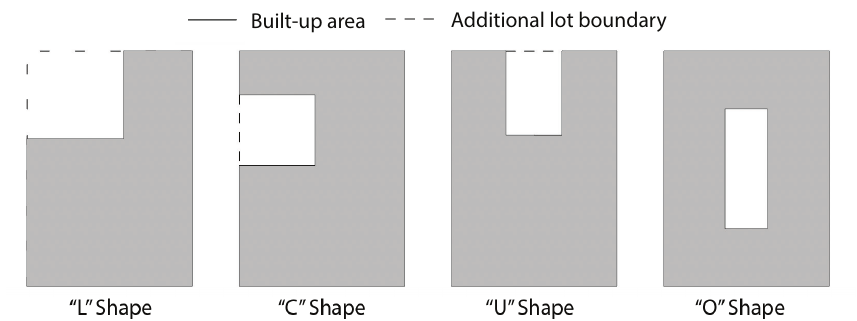
Figure 2. Sobrado massing types on the buildable urban